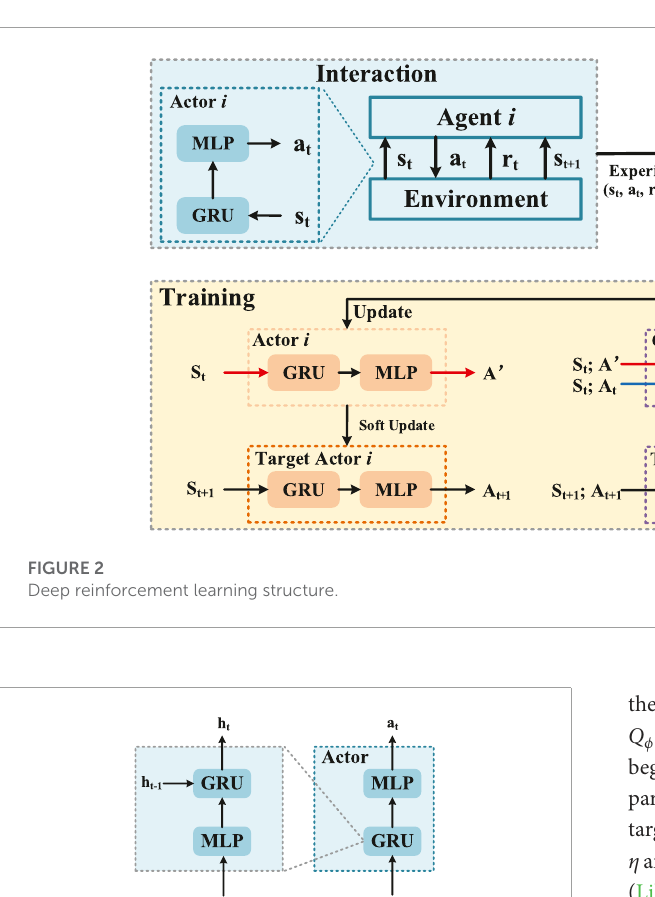
FIGURE 3 Structure of the actor